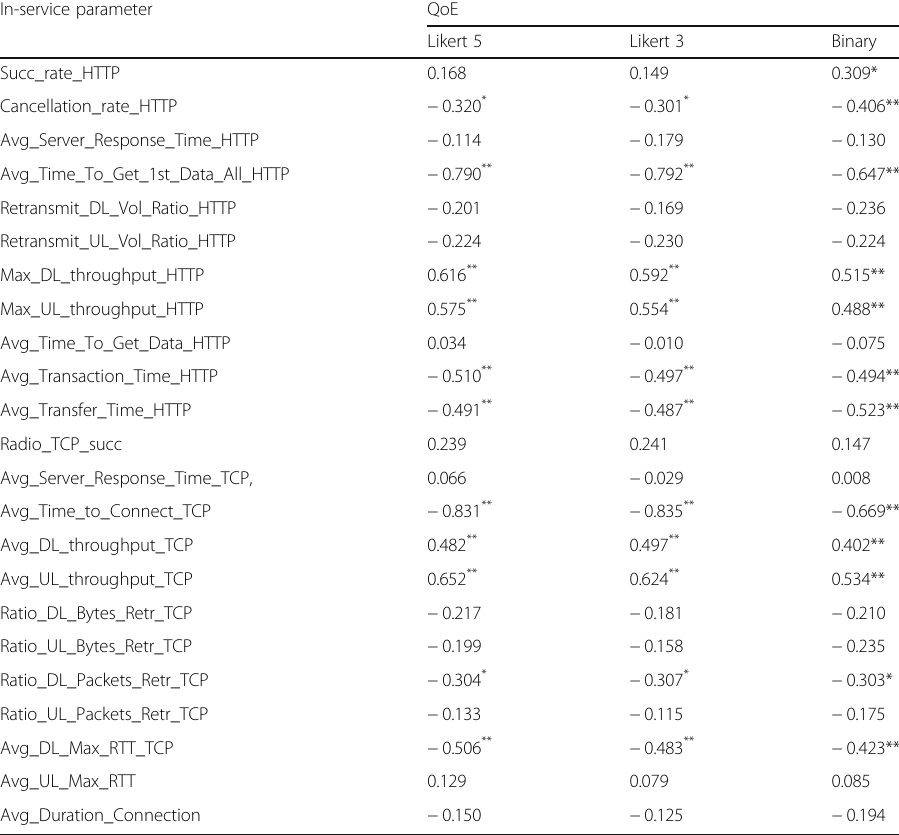
Table 1 Spearman correlation coefficient between QoE and in-service tested parameters [15] In-service